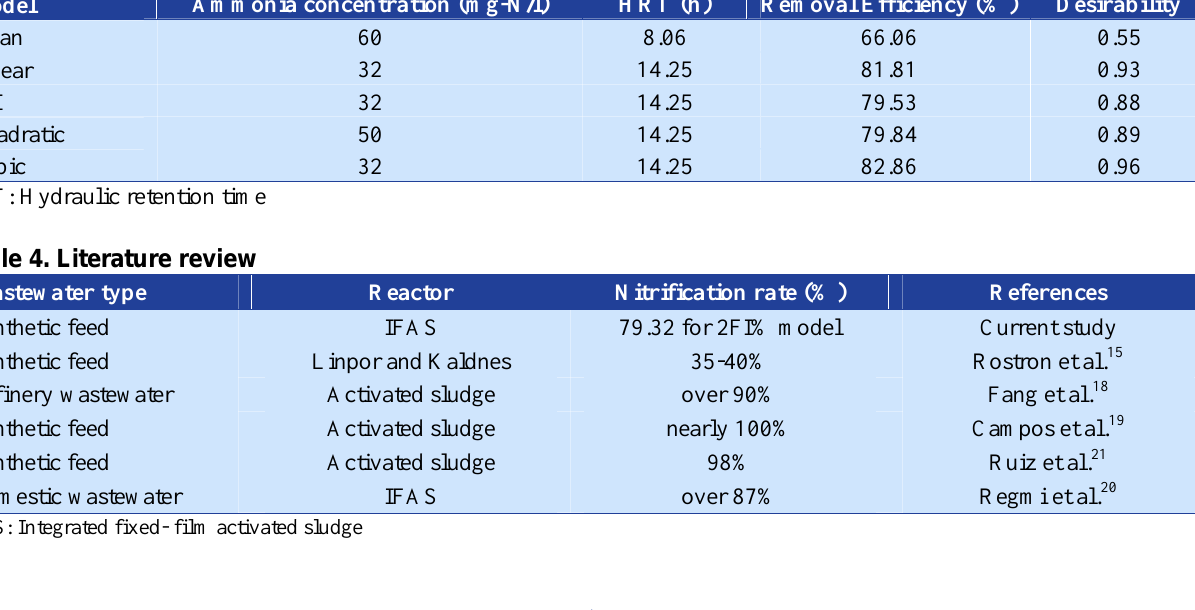
Table 3. Numerical optimal conditions and maximum predicted removal